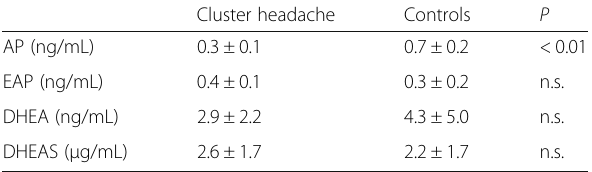
Table 4 Comparative analysis of DHEA, DHEAS, and AP levels in patients affected by episodic or chronic migraine Episodic migraine ( n = 19)